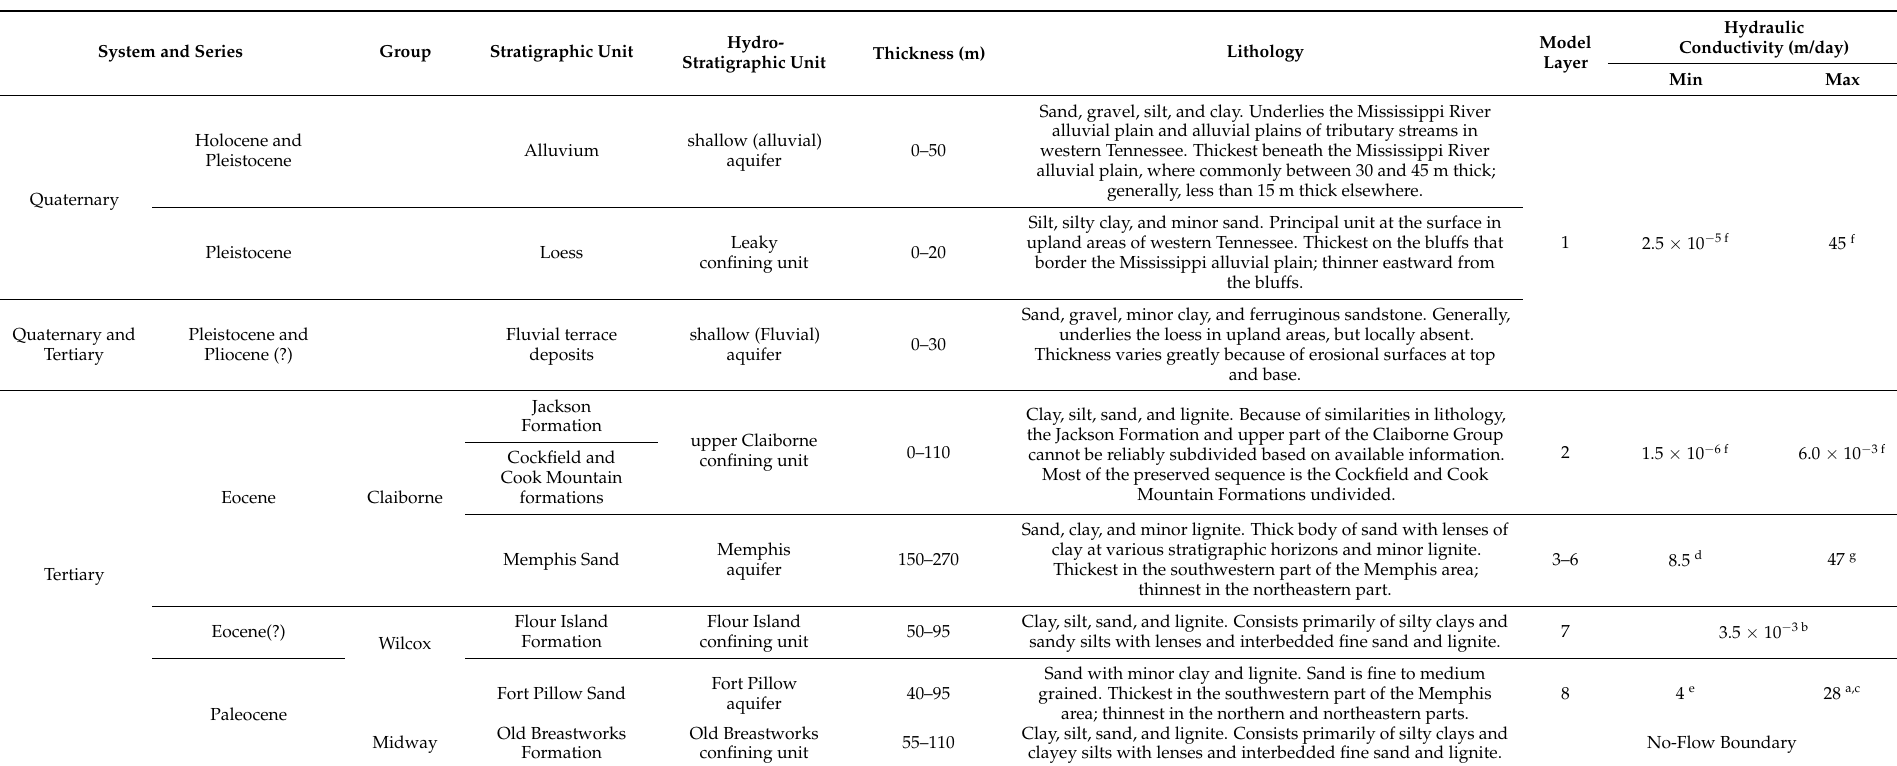
Table 1. Geologic and hydrostratigraphic units underlying Shelby County, Tennessee, with minimum and maximum values for hydraulic conductivity and model layer designation. (Adapted from Graham and Parks [32], and modified from Larsen et al.